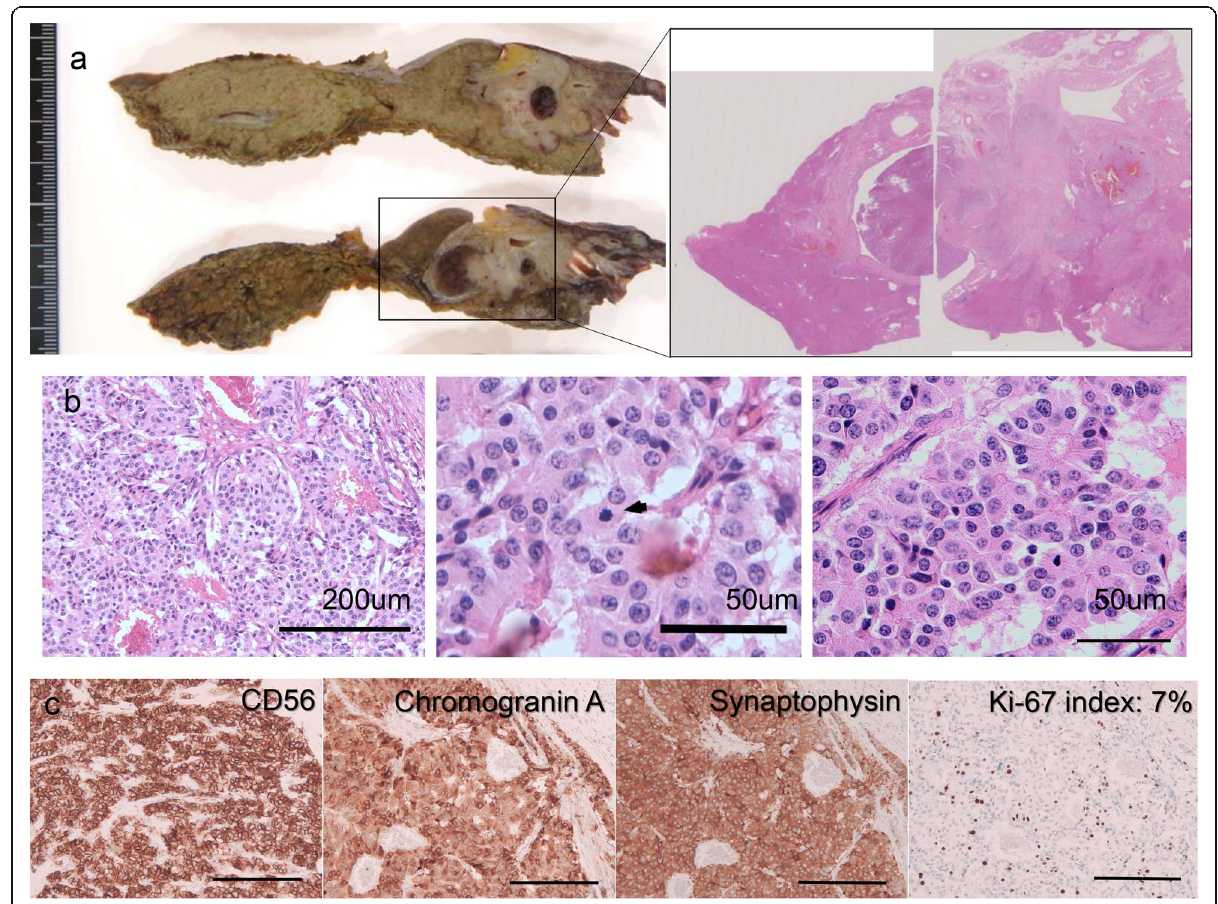
Fig. 2 Pathological findings of the initially resected specimen. a The tumor arose from the common bile duct and invaded the left hepatic bile duct. b Hematoxylin and eosin staining. The tumor nest consists of eosinophilic cells with round nuclei (left). A mitotic figure is indicated by the arrow (middle). Rosette formation is apparent (right). c Immunohistochemistry. The tumor cells are positive for all the neuroendocrine markers (CD56, chromogranin A, and synaptophysin). Ki-67 index is 7% (scale bars, 200 μ